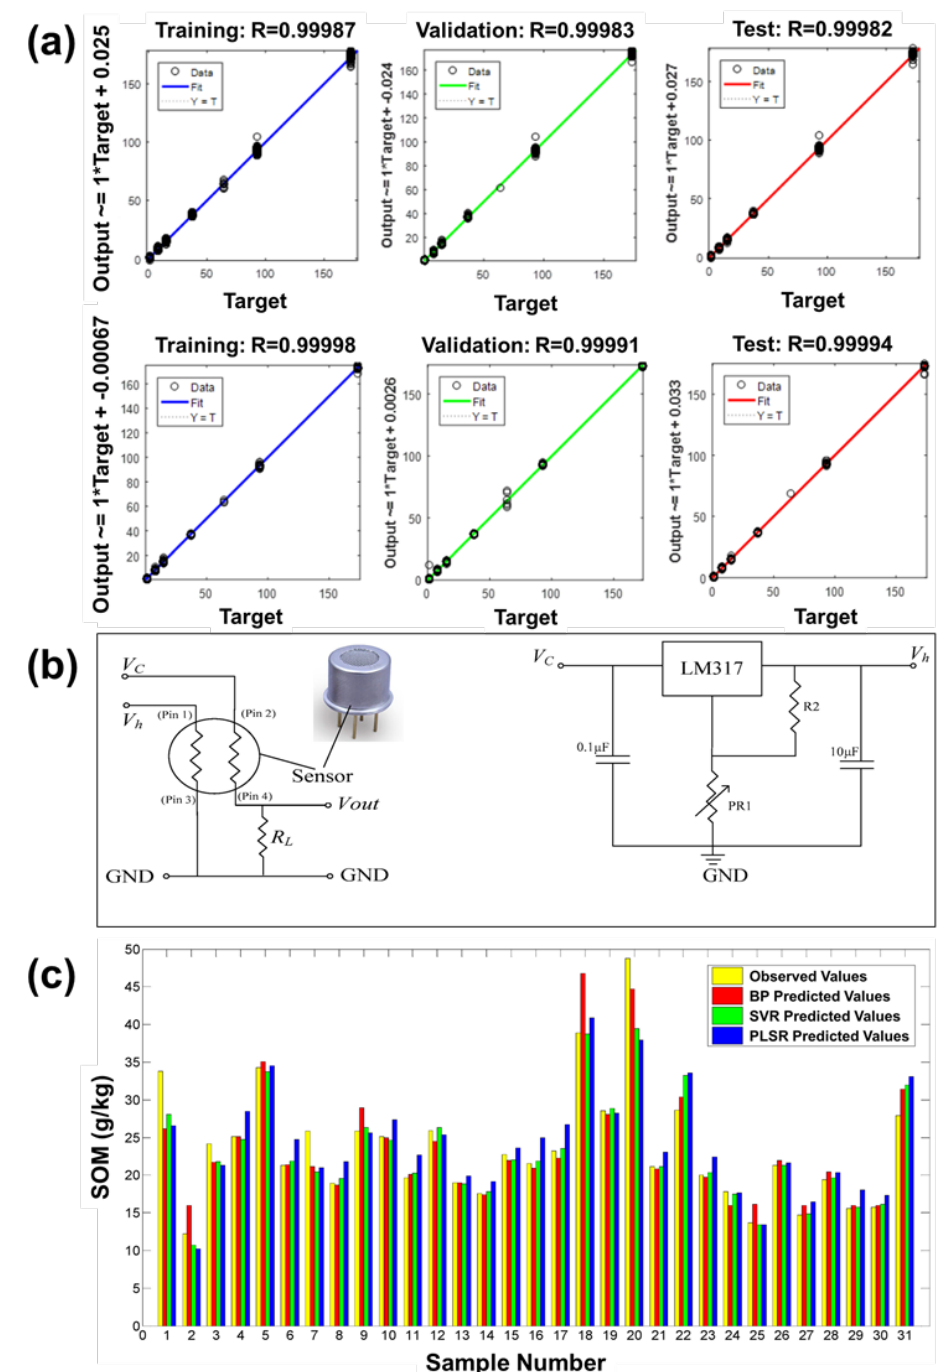
Figure 8. ( a ) ANN analysis for predicted and measured data sets evaluating the pollution with (up) and diesel (down). Reprinted with permission [115]. ( b ) Circuit diagram; ( c ) comparison of petrol (up) and diesel (down). Reprinted with permission [115] . ( b ) Circuit diagram; ( c ) compari- analysed data from different models. Reprinted with permission son of analysed data from different models. Reprinted with permission [118] .